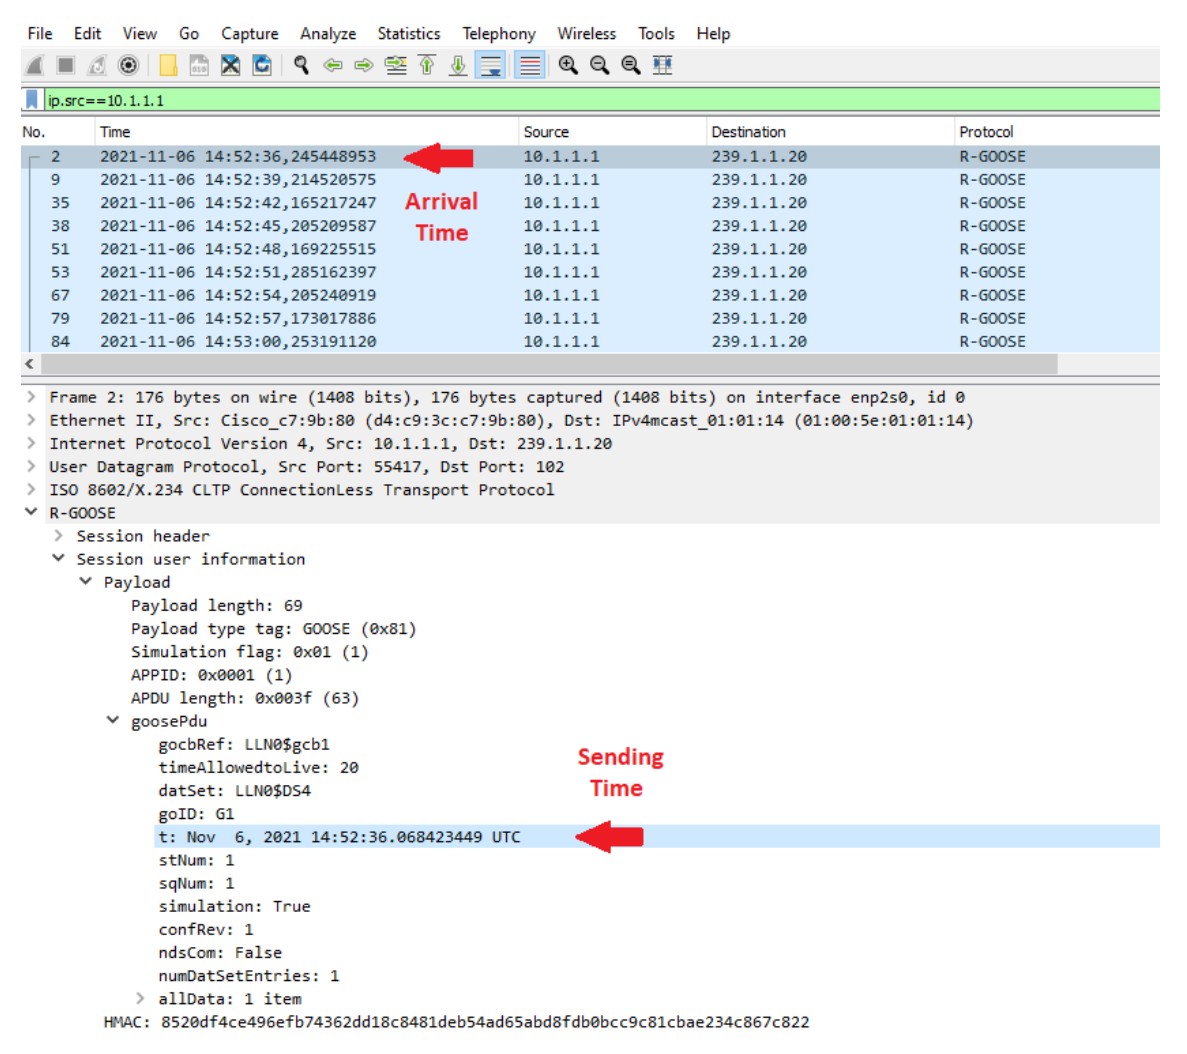
Figure 21. Sending time and arrival time of R-GOOSE message in Wireshark.